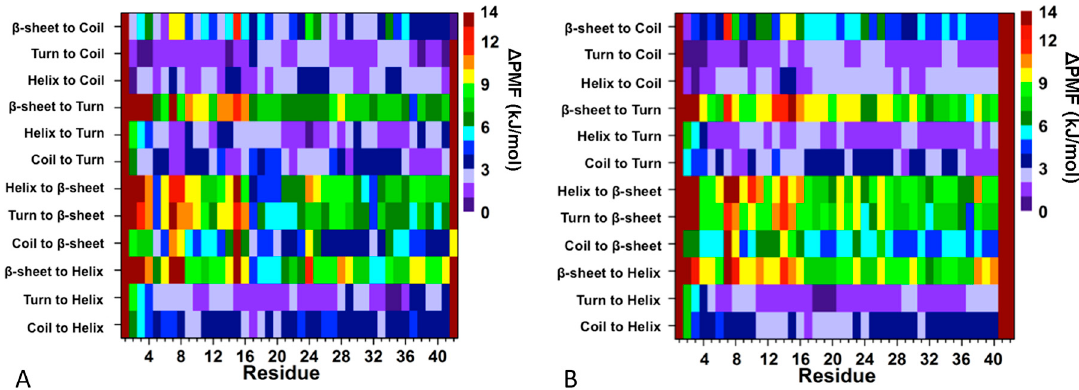
Figure 6. Secondary structure transitions between two specific secondary structure components per residue for ( A ) WT A β 42 and ( B ) the Tyr10Ala mutant in an aqueous solution medium. The color scale corresponds to the free energy values associated with specific transitions between two secondary structure components for a specific residue.